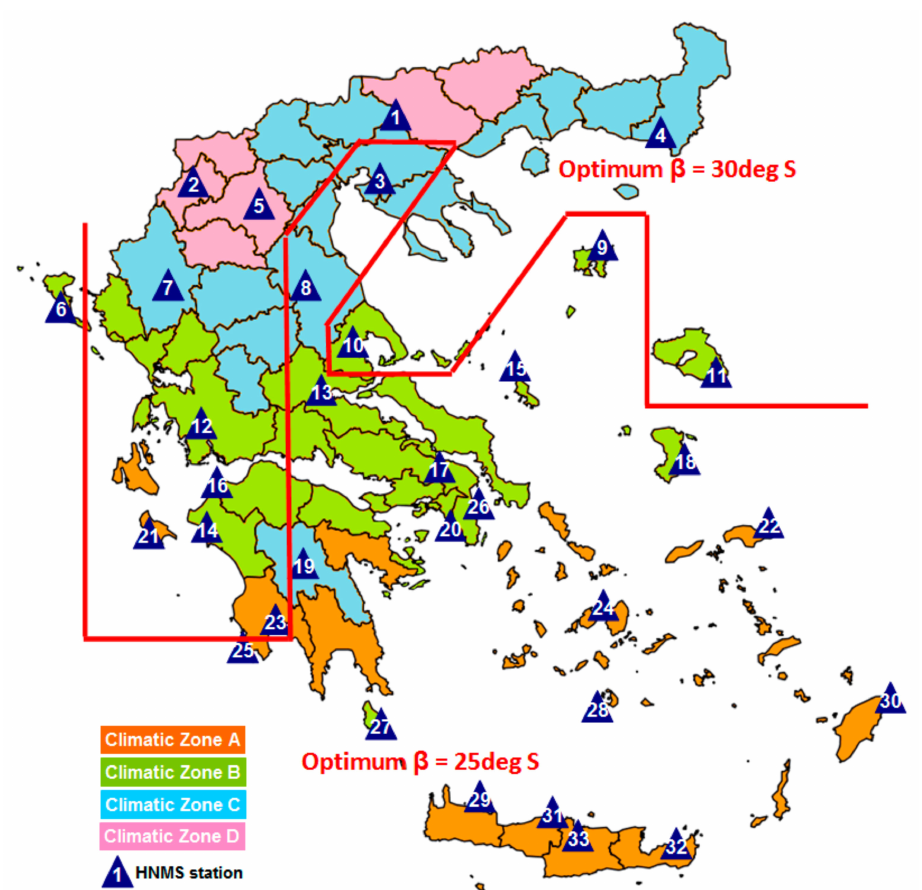
Figure 13. Spatial distribution of the optimum tilt angle β for south-facing flat-plate solar convertors in Greece for the maximum annual energy